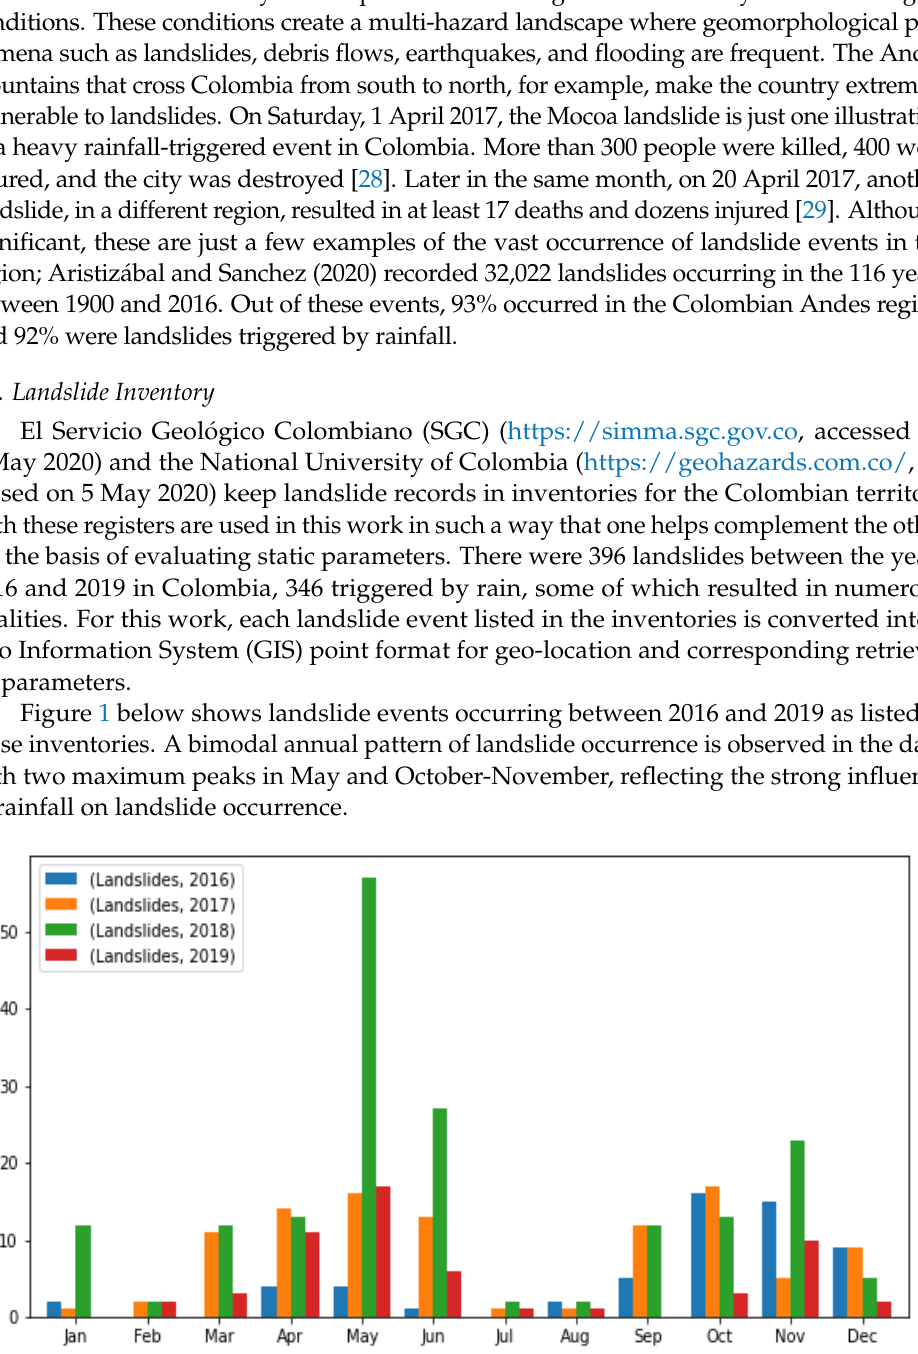
Figure 1. Landslide events in Colombia between 2016 and 2019.